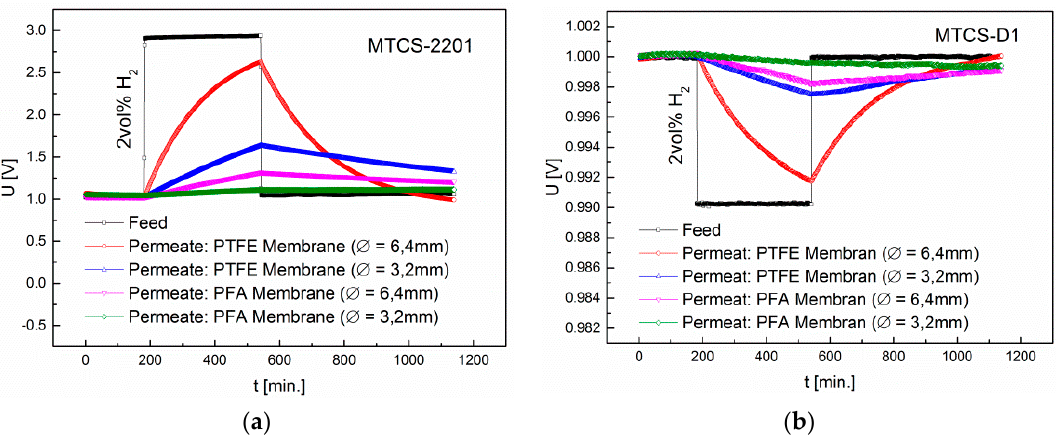
Figure 12. Influence of the diameter of a PTFE membrane on the diffusion of the gases H 2 , CO, CH 4 , ethanol, acetone and acetaldehyde. The membrane thickness is 25 µm. ( a ) Permeate signals of the MTCS-2201 sensor (pulsed operation); ( b ) Permeate signals of the MTCS-D1 sensor (isothermal operation).